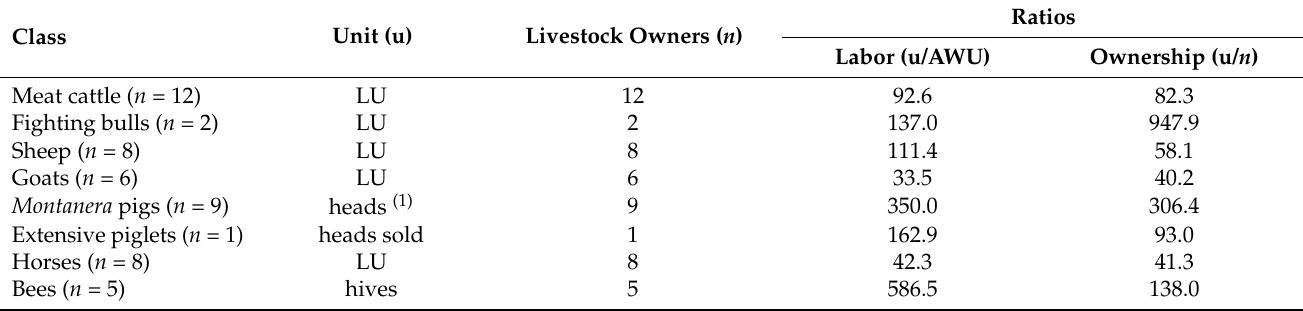
Table 2. Livestock species annual labor and ownership for large privately owned case-study dehesas in Andalusia